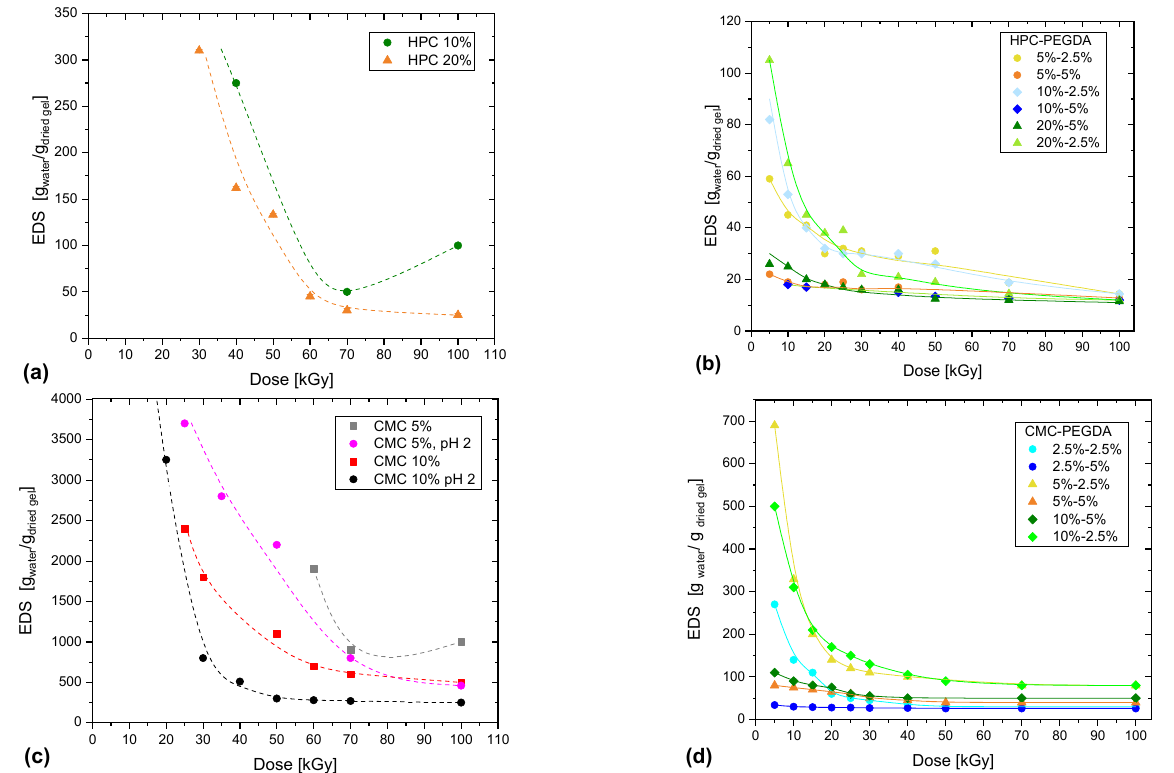
Figure 5. EDS in water of hydrogels manufactured by the irradiation of aqueous solutions of ( a ) HPC; ( b ) HPC–PEGDA; ( c ) CMC formed at two pH; and ( d ) CMC–PEGDA. Typically, the hydrogels of neat HPC and/or CMC, both polysaccharides of medium degree of substitution used in this study, swell extensively without maintaining their original form and the gel fractures into weak pieces. The crosslinker present in the system during irradiation, in addition to inducing gelation at lower doses, greatly reduces EDS. The gels maintain their dimensions—the diameter of round slabs increases moderately but they become thicker—water absorption is essentially reflected in the thickness increase—Figure 6d. In general, the EDS of two polysaccharide gels is reduced as the concentration of PEGDA increases, the examples of which are shown in Figure 6b,c. As indicated in Table 1, a roughly 3-fold smaller EDS was recorded for gels formed with 5% PEGDA than for those formed with 2.5% of the crosslinker. Nevertheless, the high content of polysaccharides in the hydrogels with PEGDA induces higher swelling. This may indi- cate lower the crosslinking density of the network: polysaccharide scission causes the cre- ation of larger voids as compared to the network of lower polymer content. Moreover, the involvement of a highly hydrophilic character due to the hydroxyls and carboxyls of cel- lulose itself and the substituent groups enhances the water uptake.